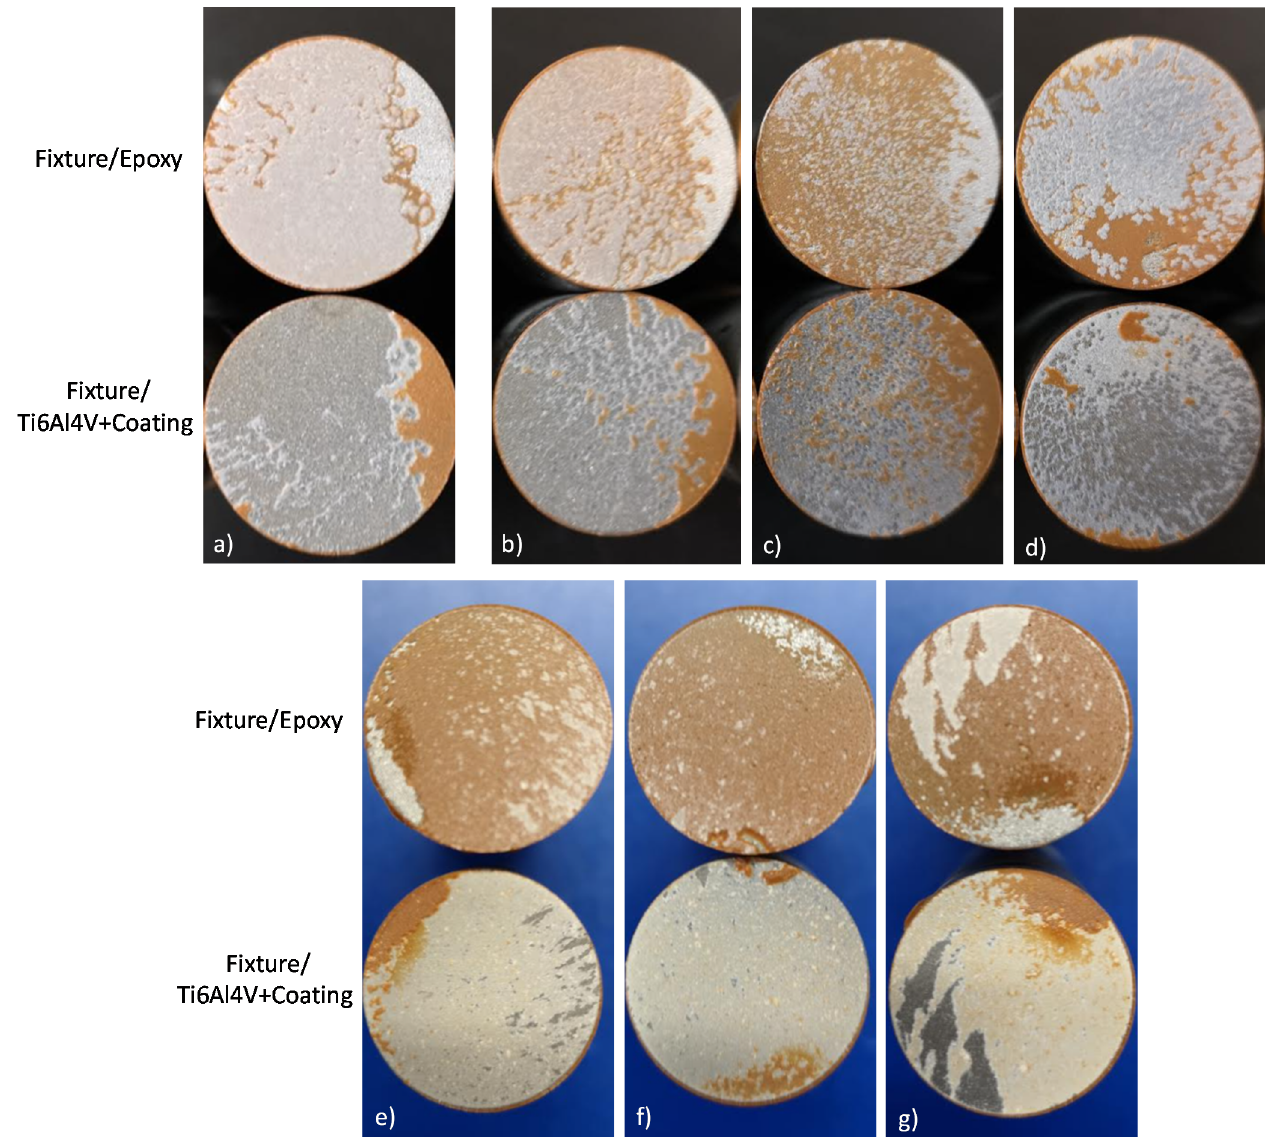
Figure 14. Visual analysis for determination of cohesive/adhesive failure-type of coatings according to ASTM C633; ( a ) HA coating; ( b – d ) coatings development by MSH (HA10BT S, HA30BT S, and HA50BT S respectively); ( e – g ) coatings development by HEBM powder homogenization process (HA10BT BM, HA30BT BM, and HA50BT BM respectively).